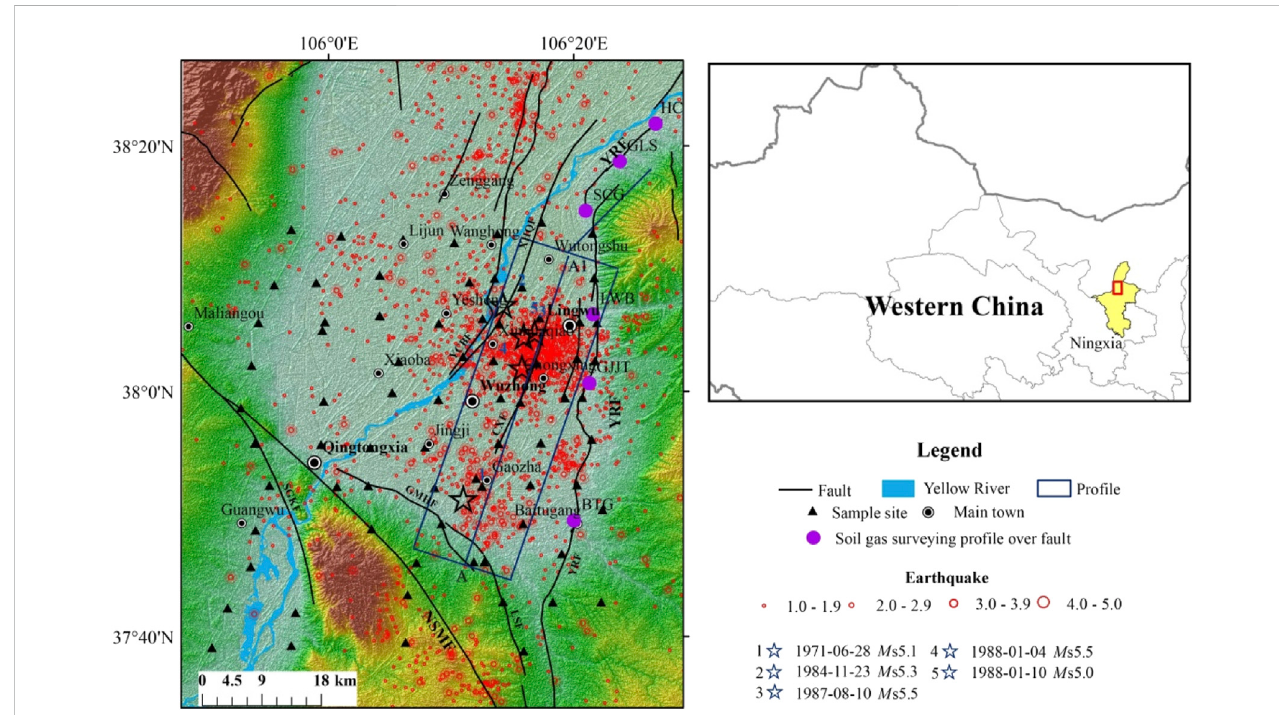
FIGURE 1 Topographical map of the study region showing the main faults, earthquake epicenters, and sampling locations. Abbreviations of the pro fi les: BTG, Baitugangpro fi le;GJJT,Guojiajiantanpro fi le;LWB,Lingwubeipro fi le;SCG,Shuangchagoupro fi le;GLS,Ganlusipro fi le;HC,Hengchengpro fi le.Abbreviations ofthefaults:YRF,YellowRiverfault;NSMF,NiushouMountainfault;SGKF,Sanguankoufault;LSF,Luoshanfault;CXF,Chongxingfault;XHQF,Xinhuaqiaofault YCBF, Yinchuan blind faul.